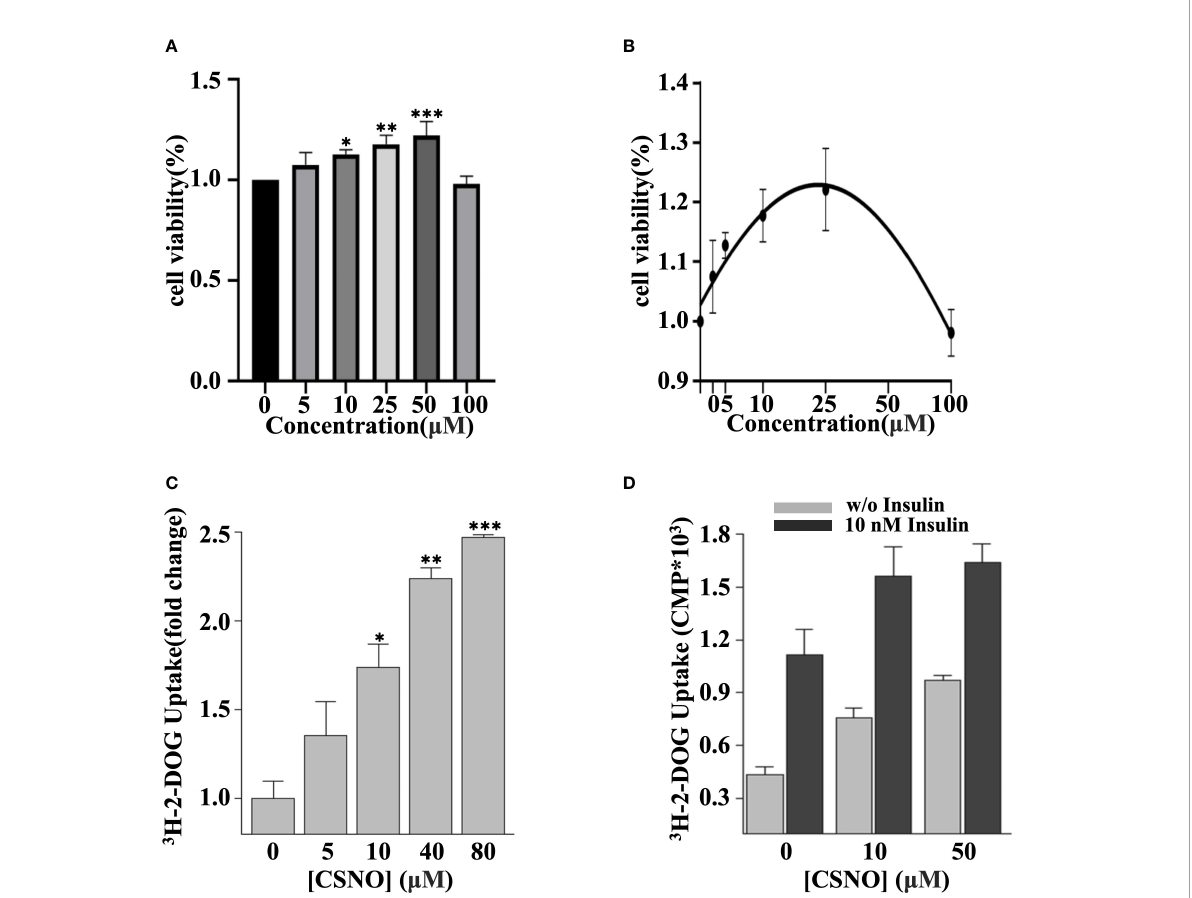
FIGURE 3 CSNO promoted cellular glucose uptake. (A) H9c2 cells were incubated with CSNO at different concentrations for 1 h. Cell viability was examined using a CCK8 kit. (B) The corresponding curve diagram of cell viability. (C) CSNO promoted cellular glucose uptake in a concentration-dependent manner. (D) CSNO increased insulin-dependent and noninsulin-dependent glucose uptake. * represents p < 0.05; ** represents p < 0.01; *** represents p <